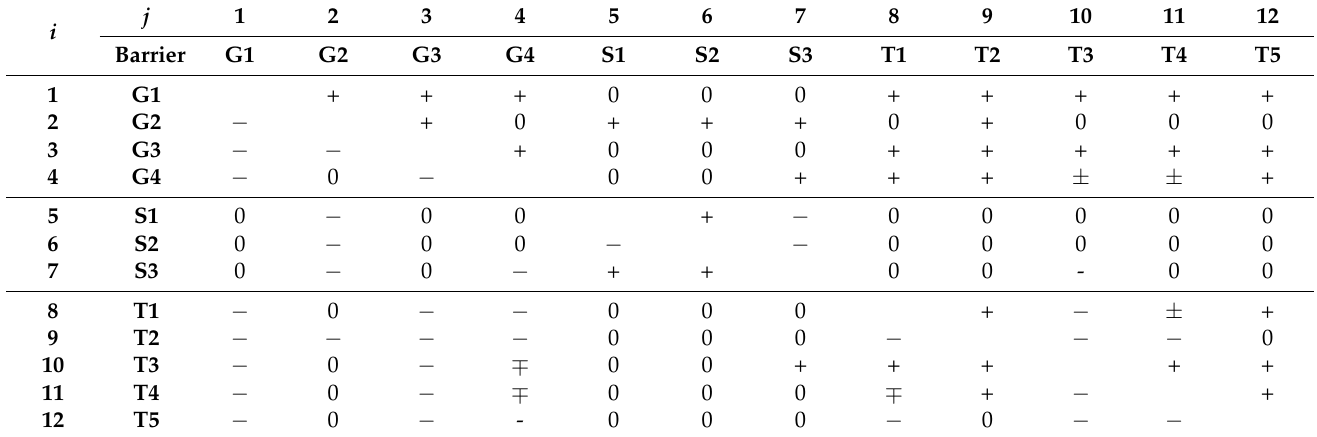
Table 4. Final Structural Self-Interaction Matrix (final